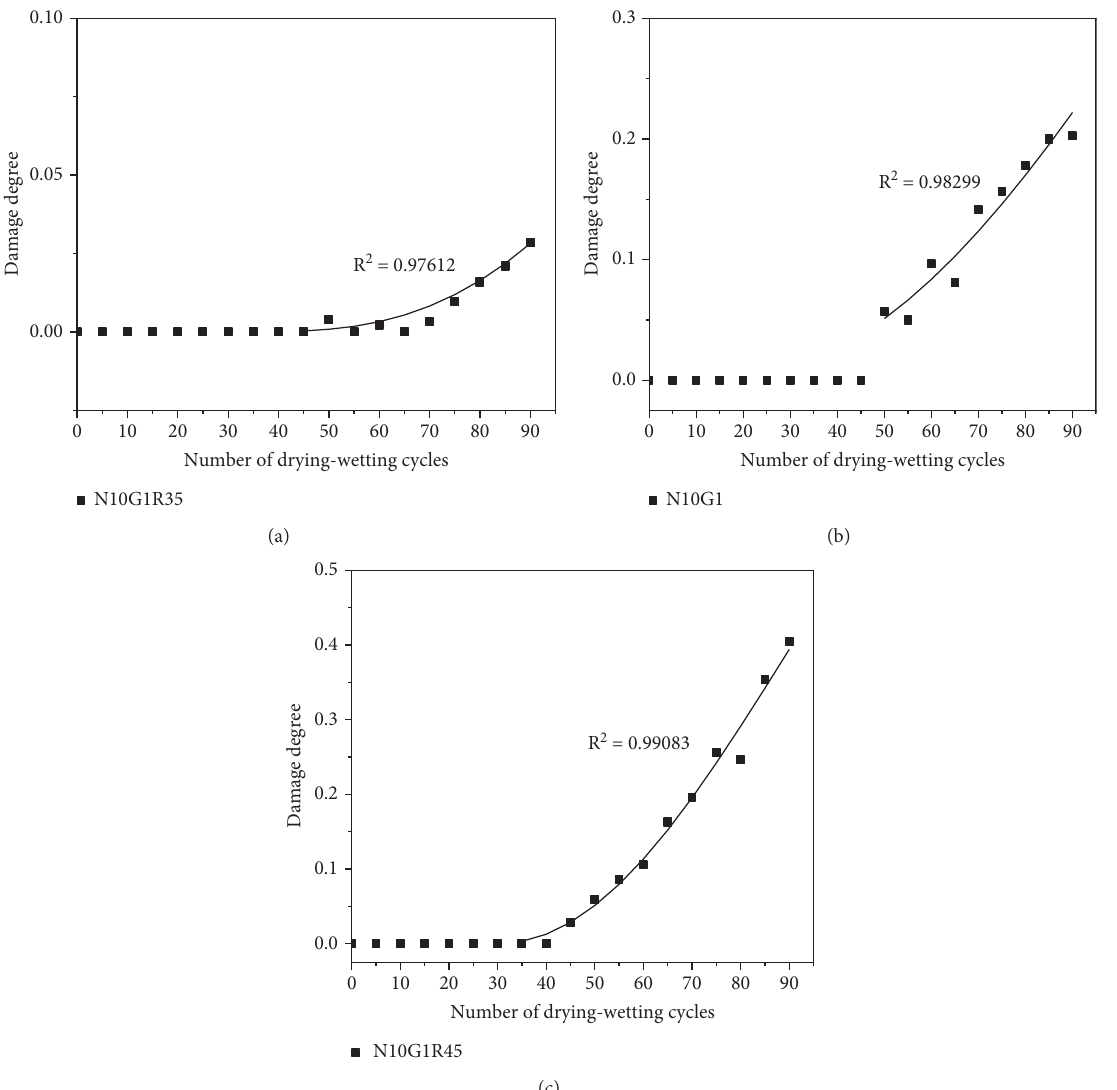
Figure 8: Variation of the concrete damage degree with different water-binder ratios. (a) N10G1R35. (b) N10G1. (c)